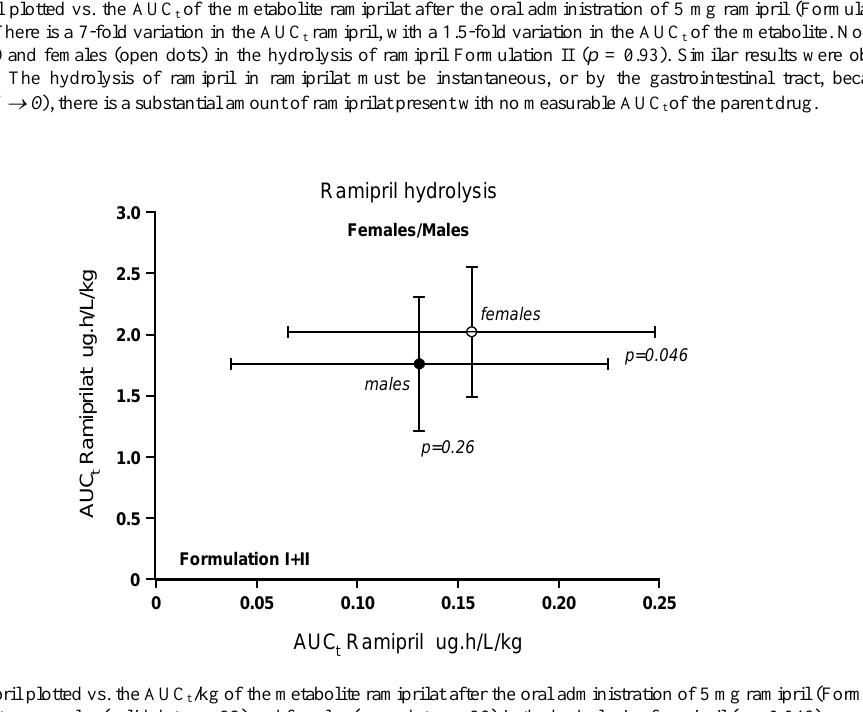
In Fig. 5, two male subjects (#2 and #27), appeared to be slow hydrolysers, all other subjects hydrolyse ramipril in a comparable manner. The whole group can be split into two apparent subgroups, with different slopes of the regression lines ( p < 0.0001), and with different Y-intercepts ( p =